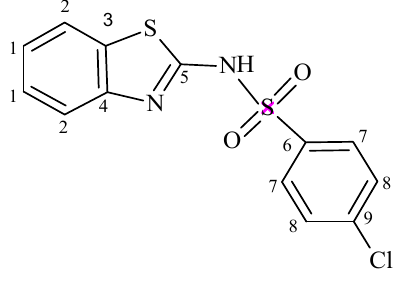
Figure 4. Structure of the ligand showing carbon numbering.